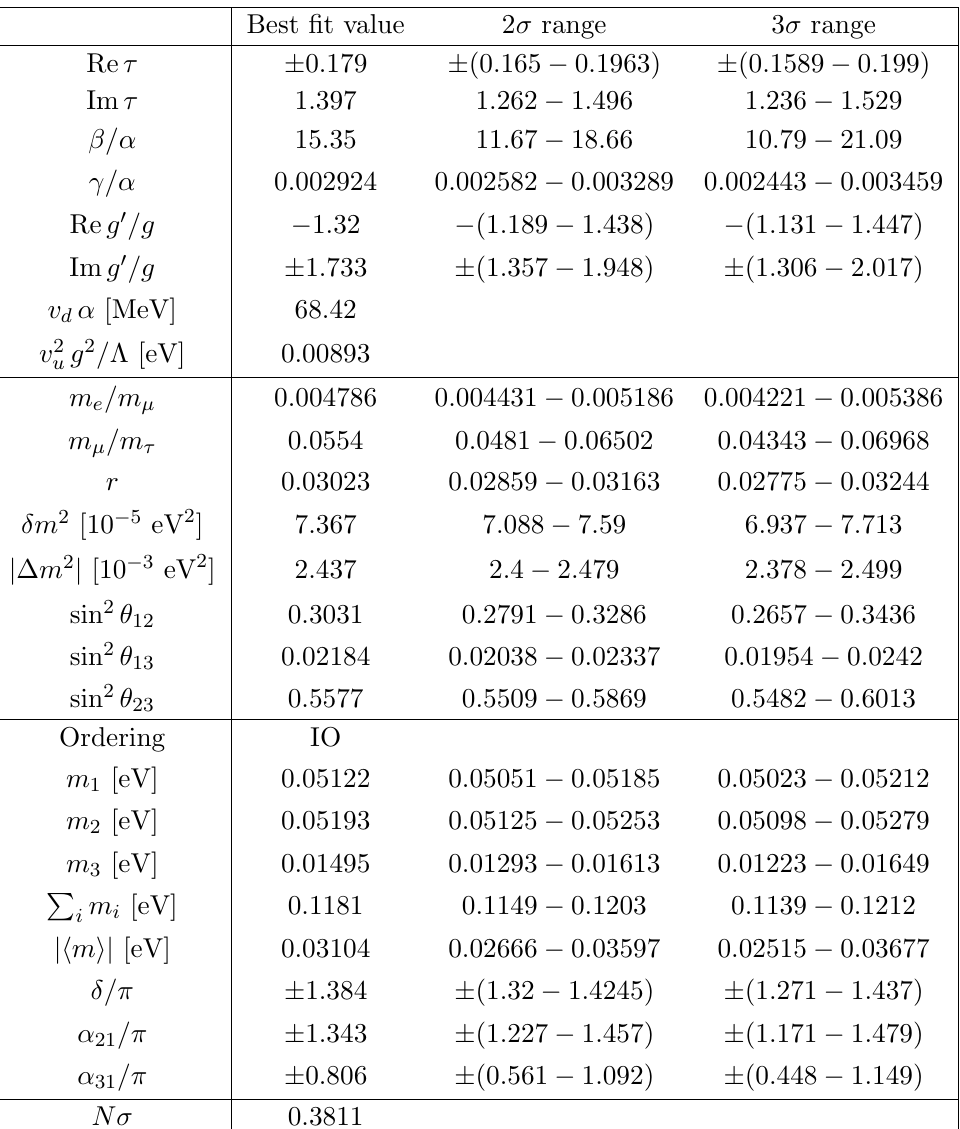
Table 5d. Best (cid:12)t values along with 2 (cid:27) and 3 (cid:27) ranges of the parameters and observables in cases D and D (cid:3) , which refer to ( k (cid:3) ; k g ) = (0 ; 2) and to a certain region in the (cid:28) plane (see (cid:12)gure